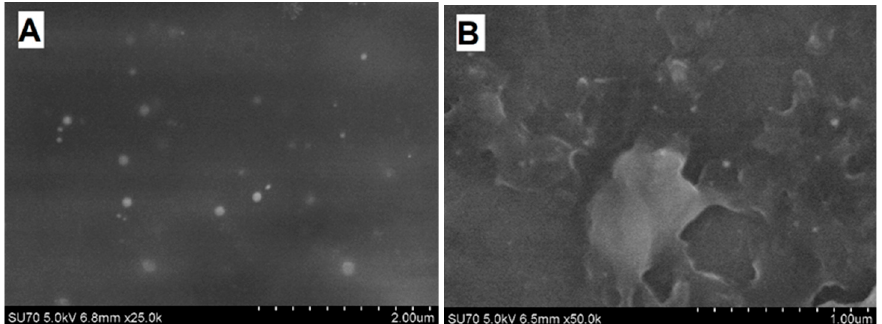
Figure 7. FE-SEM images of PANI/GOx ( A ) and Ppy/GOx ( B ) composite nanoparticles after 24 h lasting enzymatic polymerization. (The polymerization solution: 0.05 mol L − 1 SA buffer, pH 6.0, with 0.05 mol L − 1 of glucose, 0.75 mg mL − 1 of GOx, and 0.50 mol L − 1 of aniline or pyrrole).